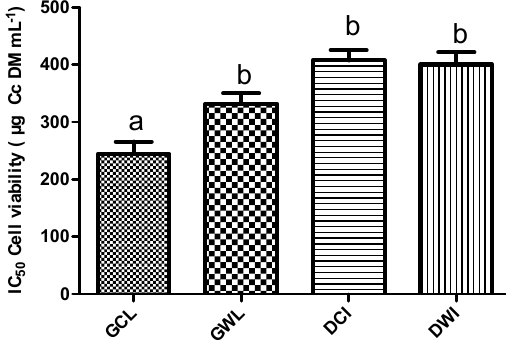
Figure 7. Anti-proliferative effect of Cc extracts on MDA-MB-231 cells, expressed in . Each value represents the mean ± S.D. of three determinations. At least one terms of IC 50 same letter means no significant differences at P ≤